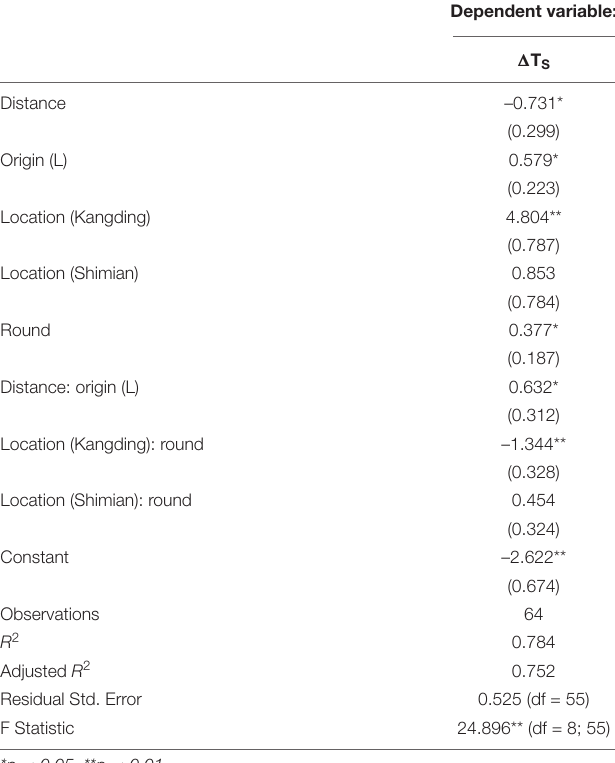
TABLE 3 | Results from linear models with interactive effects on (cid:49) T S